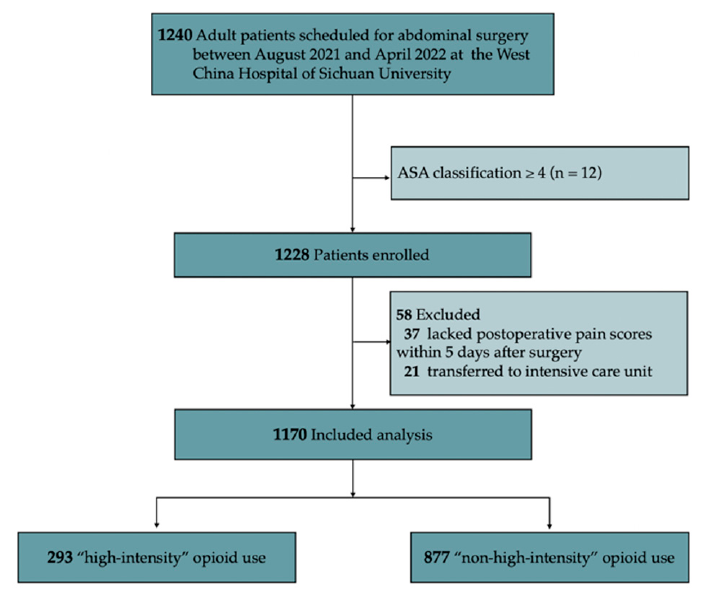
Figure 1. Flow chart of patient enrollment. Abbreviations: ASA, American Society of Anesthesiologists.